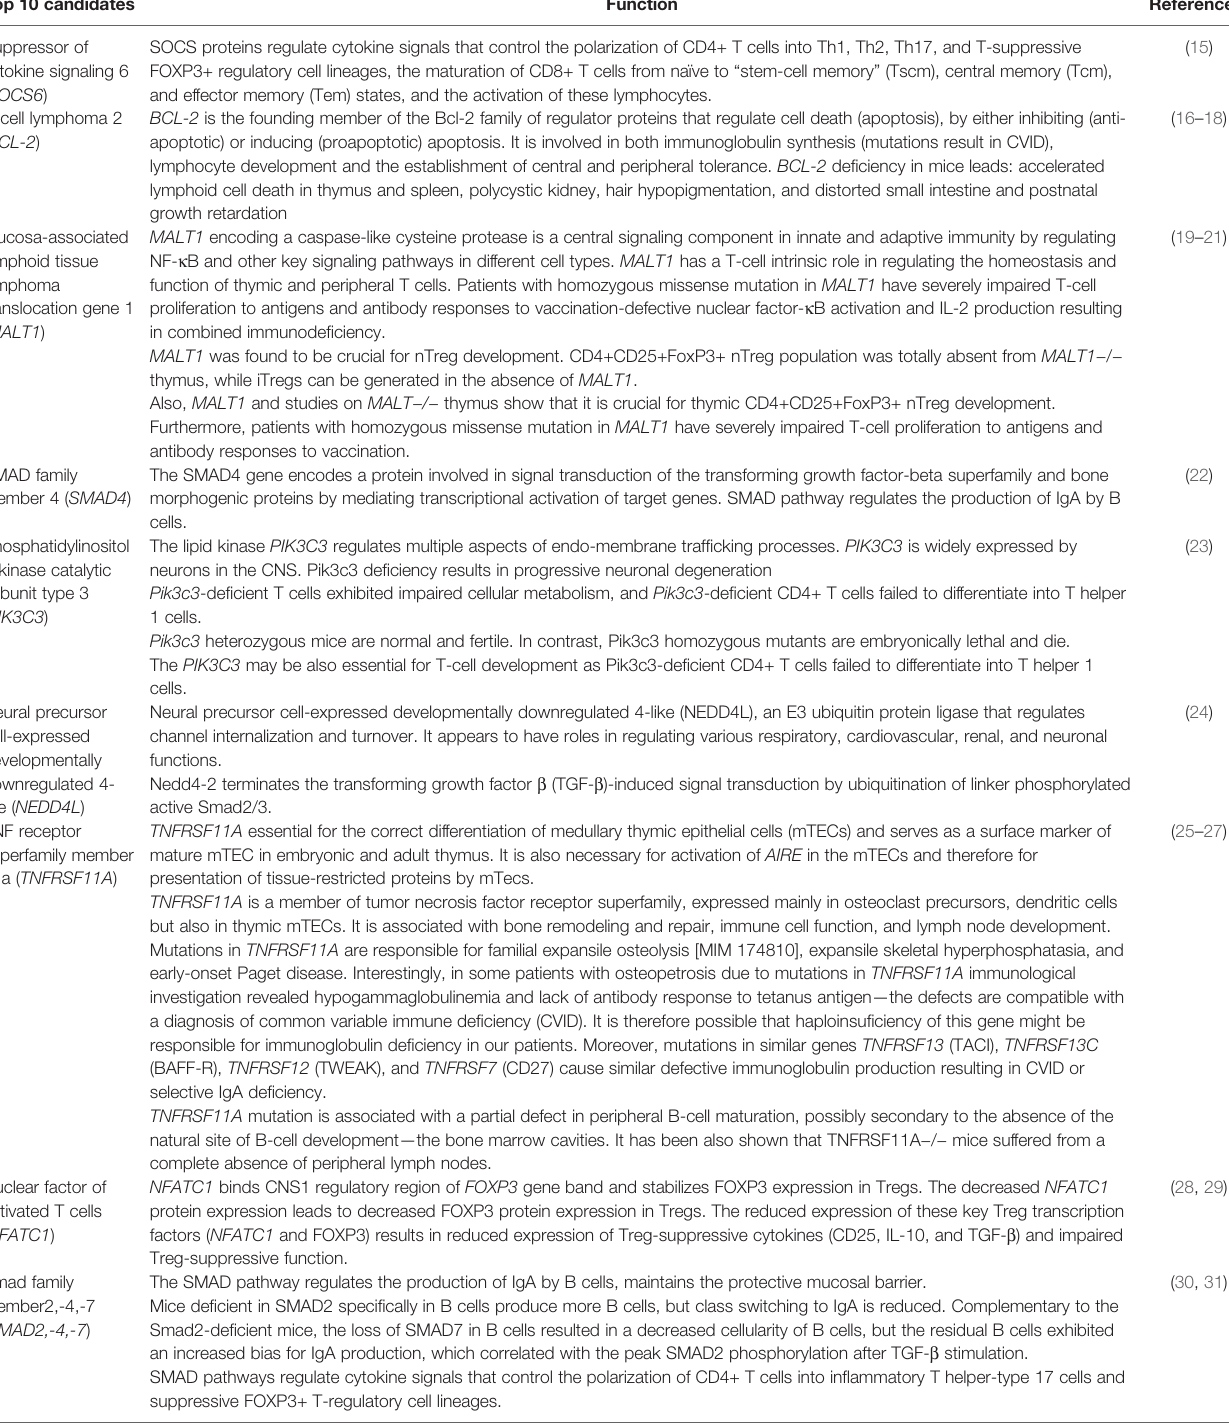
TABLE 5 | Known functions of top 10 candidate immunogenes located on